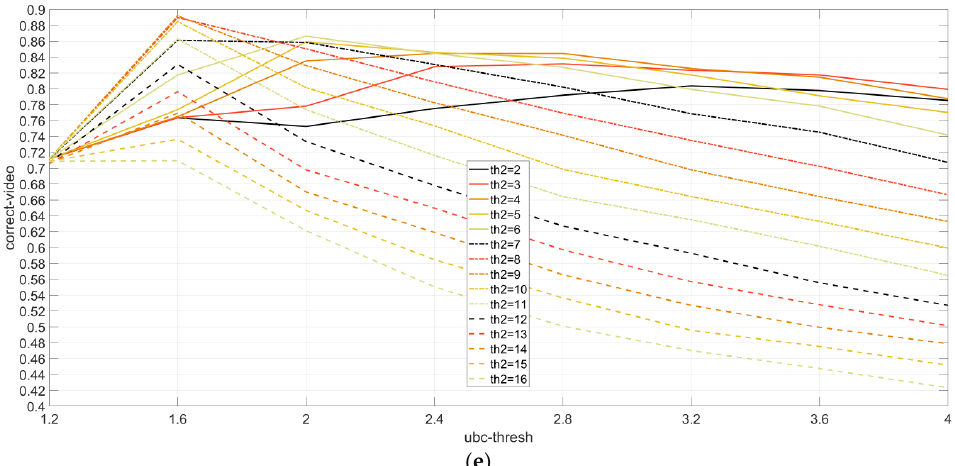
Figure 20. Examples of video searching by using one image query under the transformations. ( a ) Transformation AT1; ( b ) Transformation AT2; ( c ) Transformation AT4; ( d ) Transformation AT7; ( e ) Transformation AT9.